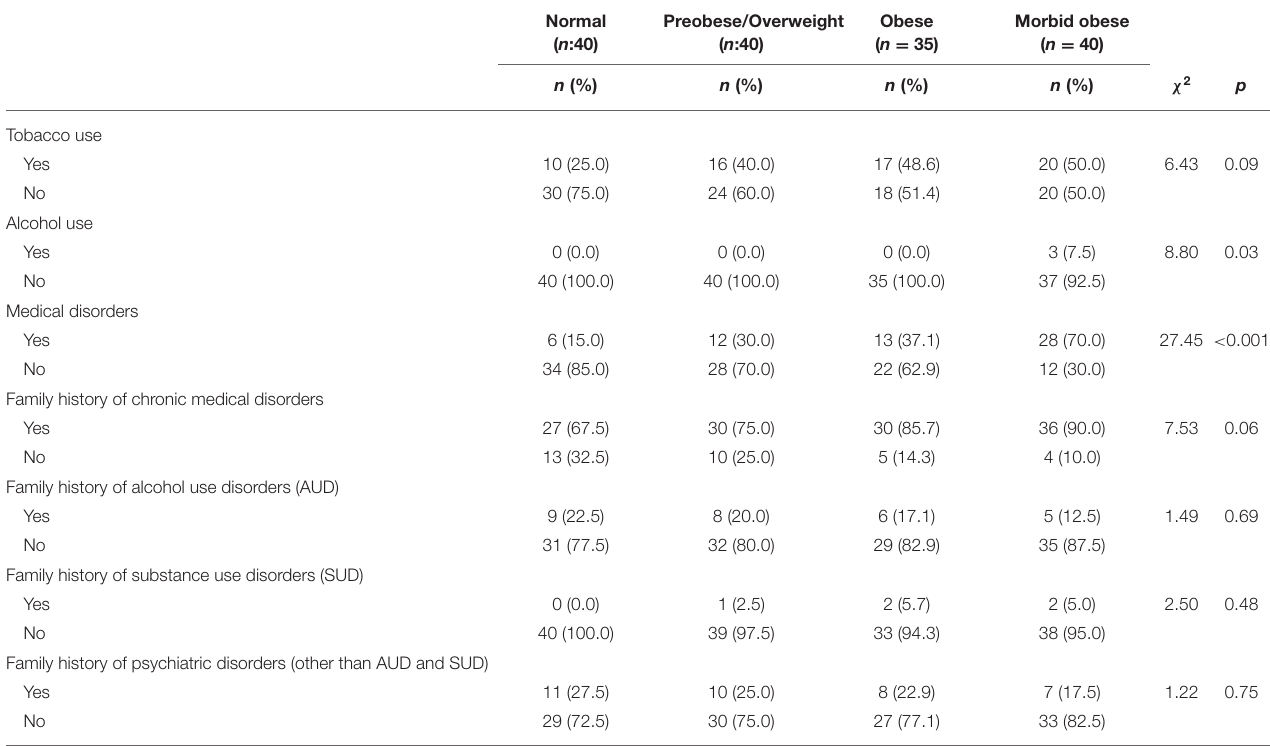
TABLE 2 | Clinical characteristics of participants.